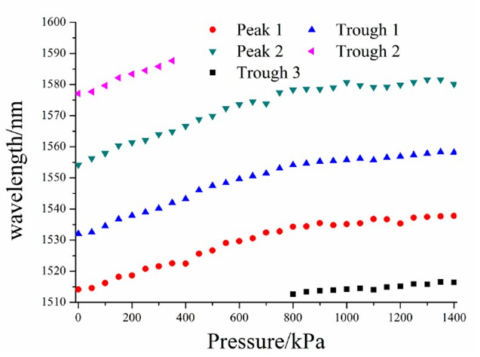
Figure 7. Relationship peak wavelength shift and filling